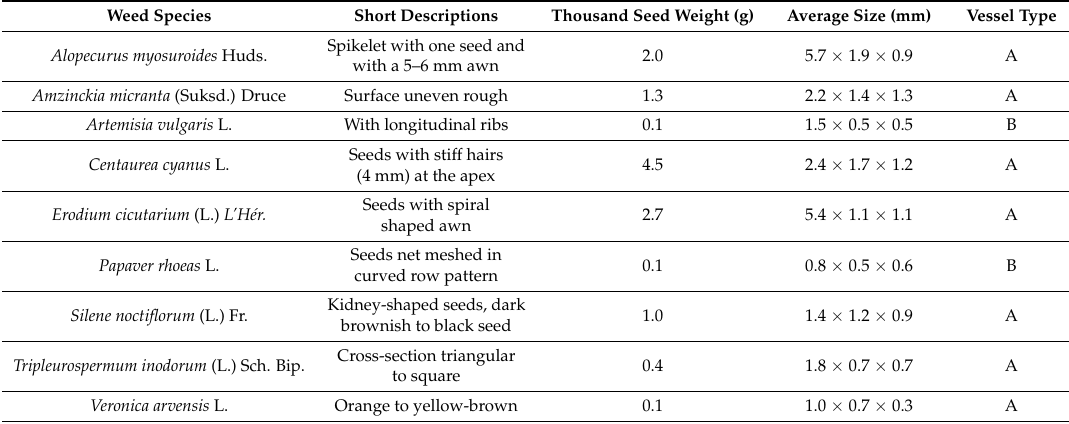
Table 1. Weed species exposed to heat treatments, characteristics of the seeds, thousand seed weight, size, and vessel type used for the species. Vessel A was made from a woven wire cloth of stainless steel with an aperture width of 0.71 mm and a wire diameter of 0.224 mm. Vessel B was made from a woven metal filter cloth with an aperture width of 0.40 mm and a wire diameter of 0.330 mm.